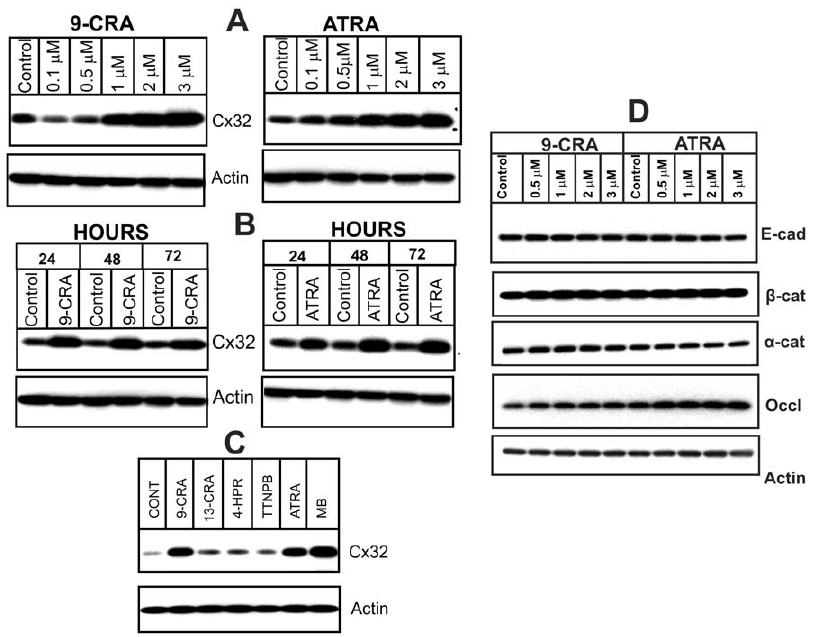
Figure 1. Retinoids increase Cx32 expression level. Cx32-expressing LNCaP-32 cells were treated with the 9-CRA, ATRA, MB and other retinoids as indicated. A . Dose-dependent enhancement of Cx32 expression level upon 9-CRA and ATRA treatment for 48 h. Note that significant enhancement is observed only at concentrations above 0.5 m M. B . Kinetics of enhancement of Cx32 expression level upon treatment with 9-CRA and ATRA (1 m M) for the indicated times. Note that enhancement is observed as early as 24 h. C . Only 9-CRA and ATRA and MB increase Cx32 expression level. Note that RAR-specific retinoids, TTNPB (tetrahydrotetramethyl-nepthalenylpropanylbenzoic acid), and 13-CRA (13-cis-retinoic acid) and the other unrelated retinoid,4-HPR, are ineffective. Note that MB (2.5 nM) is at least 300–500 times more potent than 9-CRA and ATRA on equimolar basis. D . Effect of 9-CRA and ATRA on adherens and tight junction associated proteins. Expression of adherens junction associated proteins E-cadherin and a - and b -catenins, and tight junction associated protein, occludin, was analyzed by Western blot analysis of total cell lysate (5 m g). Note that only the expression of occludin appears to change noticeably.